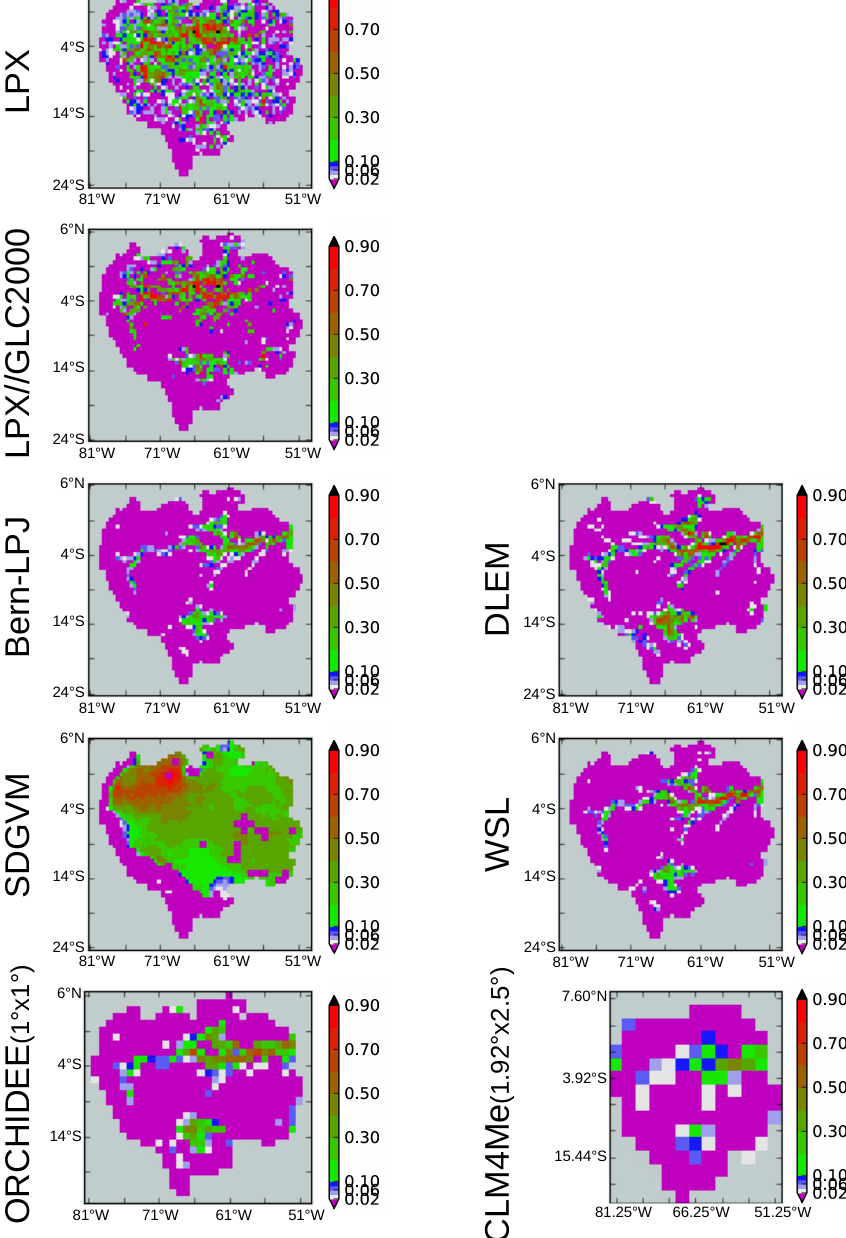
Fig. 9. Wetland extents (total grid-cell fraction, unitless) for LPX (top line) and six models participating in WETCHIMP. The second line (LPX//GLC2000) corresponds to the same wetland extent as shown in the first line after filtering for grid cells that contain floodplains in